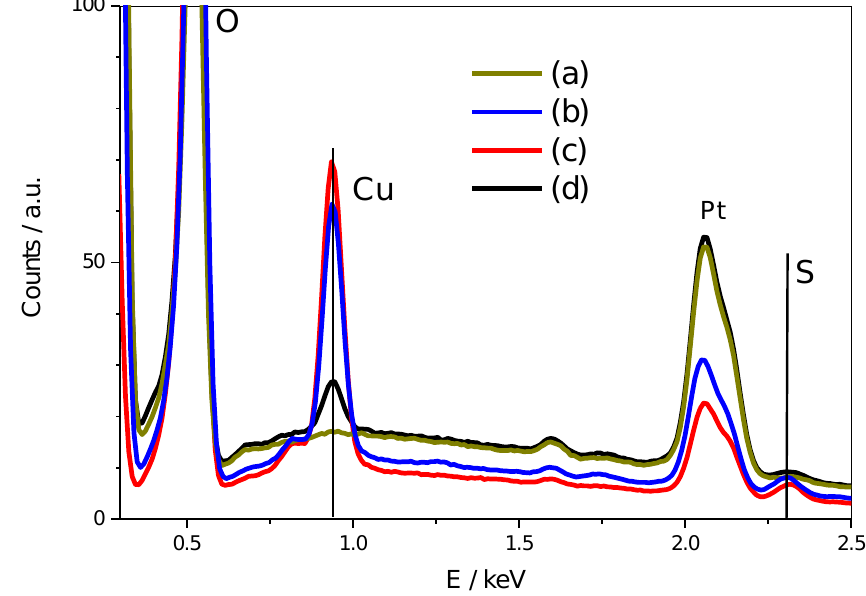
Figure 2. Energy-dispersive X-ray (EDX) spectra of PEEK samples, treated with CuSO 4 solution. ( a ) Plain PEEK; ( b ) PEEK surface modified with polyethylene imine (PEI) during molding; ( c ) after extraction in ethanol; ( d ) after extraction in water at pH 3. The signals are marked with assigned elements. The Pt signals stem from the preparation procedure.